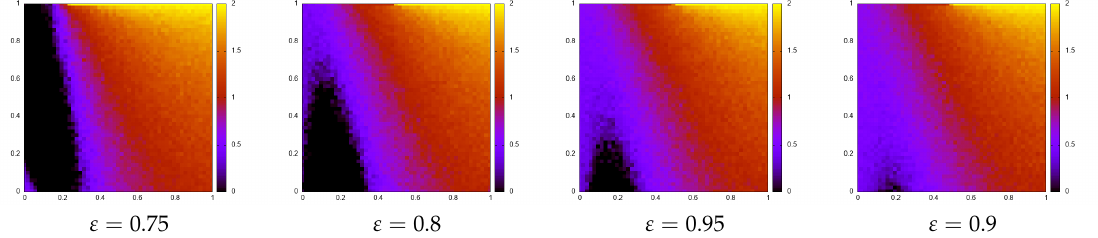
Figure 6. Phase space of directed percolation with interacting colors, case (b). The vertical axes is p and the horizontal one is q . In this case, (disruptive interference among layers) the active region tends to occupy the whole line p =